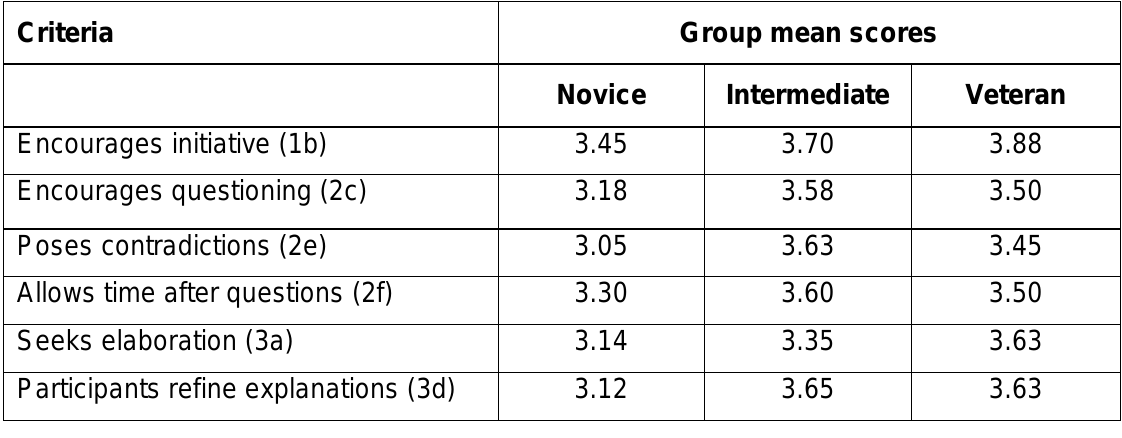
Table 1. Comparison of respondents’ mean scores with regard to questions on the belief system